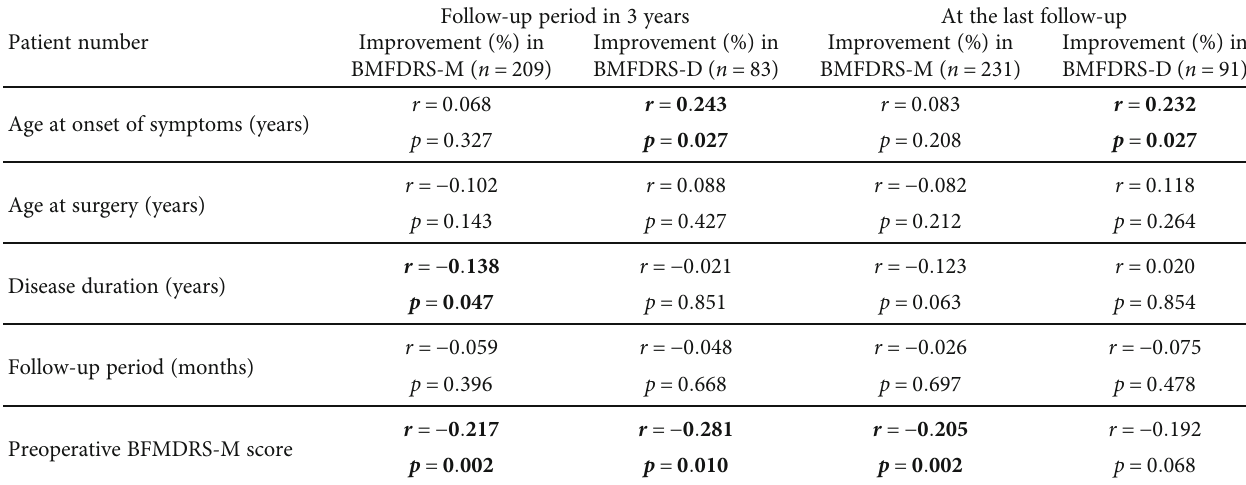
Table 4: Relationship between several factors and relative improvement (%) in